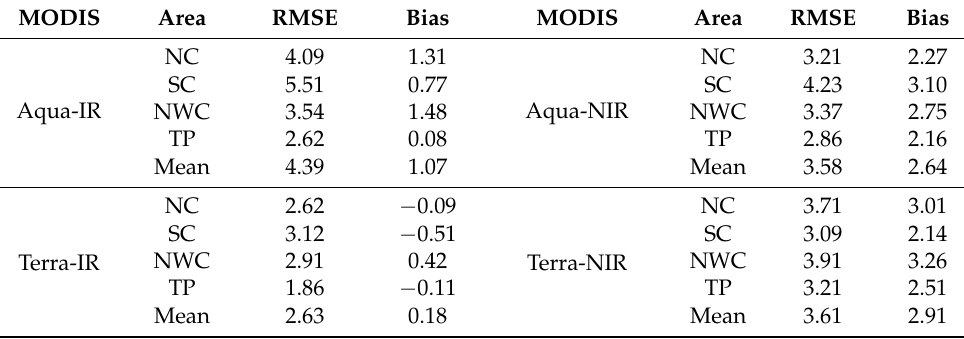
Table 5. Comparison results between Aqua/Terra MODIS PWV products and GNSS PWV [39] in the four areas over Mainland China during the period of 2000–2015 (unit: